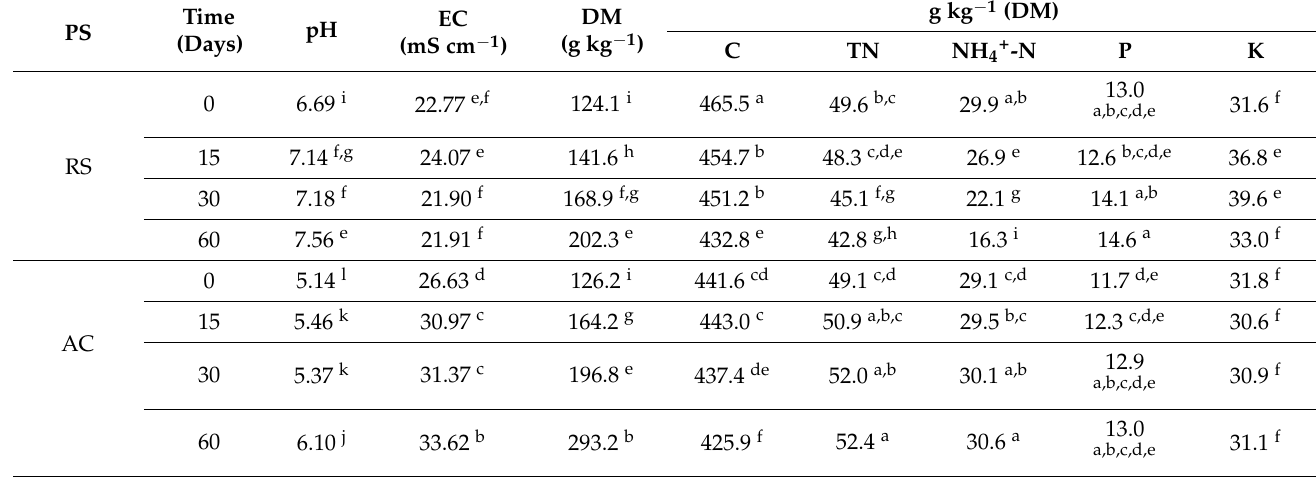
Table 6. Physicochemical analysis (pH, EC, DM, OM, TN, NH 4+ -N, P e K) of raw and treated pig slurry (PS3), in the beginning of the storage test (t = 0 d) and after 30 and 60 days (t = 15, t = 30, t = 60 d) (Mean, n = 3). Slurry samples were acidified to